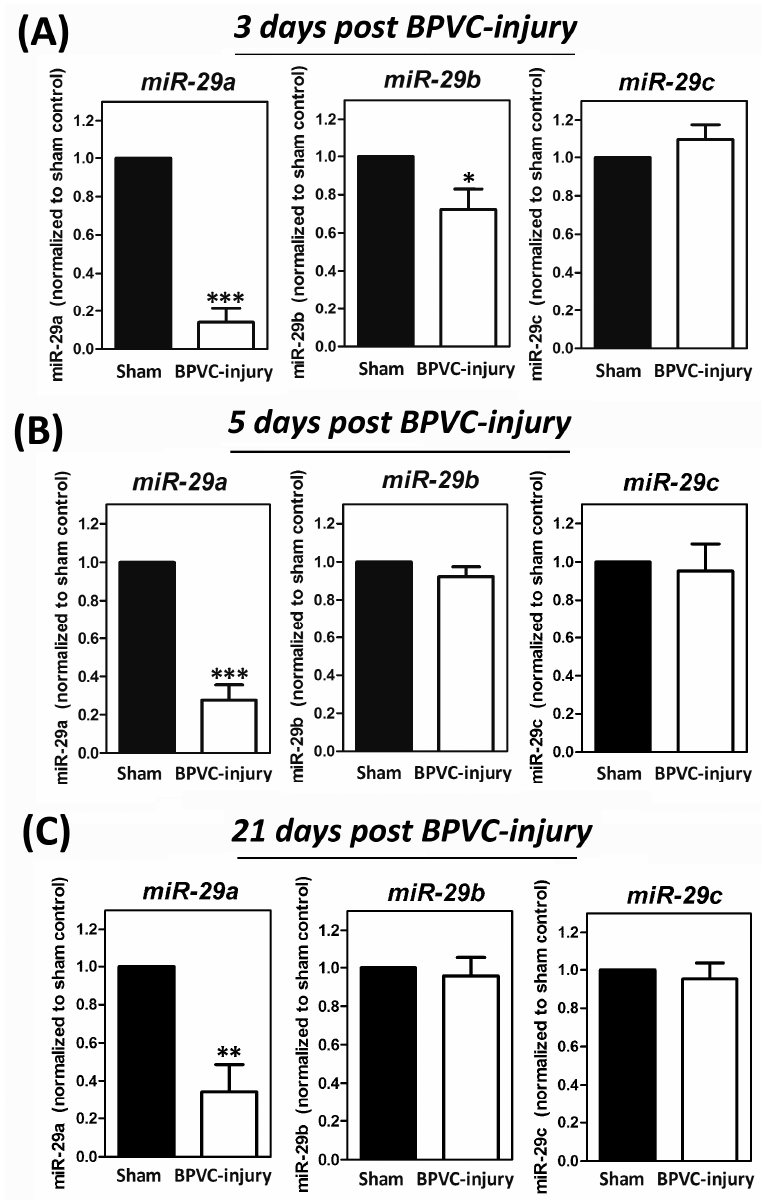
Figure 1. Downregulation of miR-29a , but not miR-29b or miR-29c in bupivacaine (BPVC)-injured group while compared with those in Sham control group ( n = 6 / each group). Sixty µ L of 1.5% ( w / v ) BPVC were injected into gastrocnemius muscles of left hind (LH) limb to induce muscle ischemic injury, and gastrocnemius muscles collected from various designated time points were extracted the total microRNA and expression levels of miR-29a , miR-29b , or miR-29c were estimated by quantitative RT-PCR analysis. Of note, consistently suppression of miR-29a levels were found on ( A ) day 3 post BPVC-injury (initiated phase of angiogenesis [12]), ( B ) on day 5 post BPVC-injury (peak phase of angiogenesis progression [12]) or ( C ) on 3 weeks post injury (peak phase of fibrotic stage [1,45]) of muscle healing. Data were given as means ± SD. * p < 0.05, ** p < 0.01, *** p < 0.001 for the BPVC group vs. the Sham group.